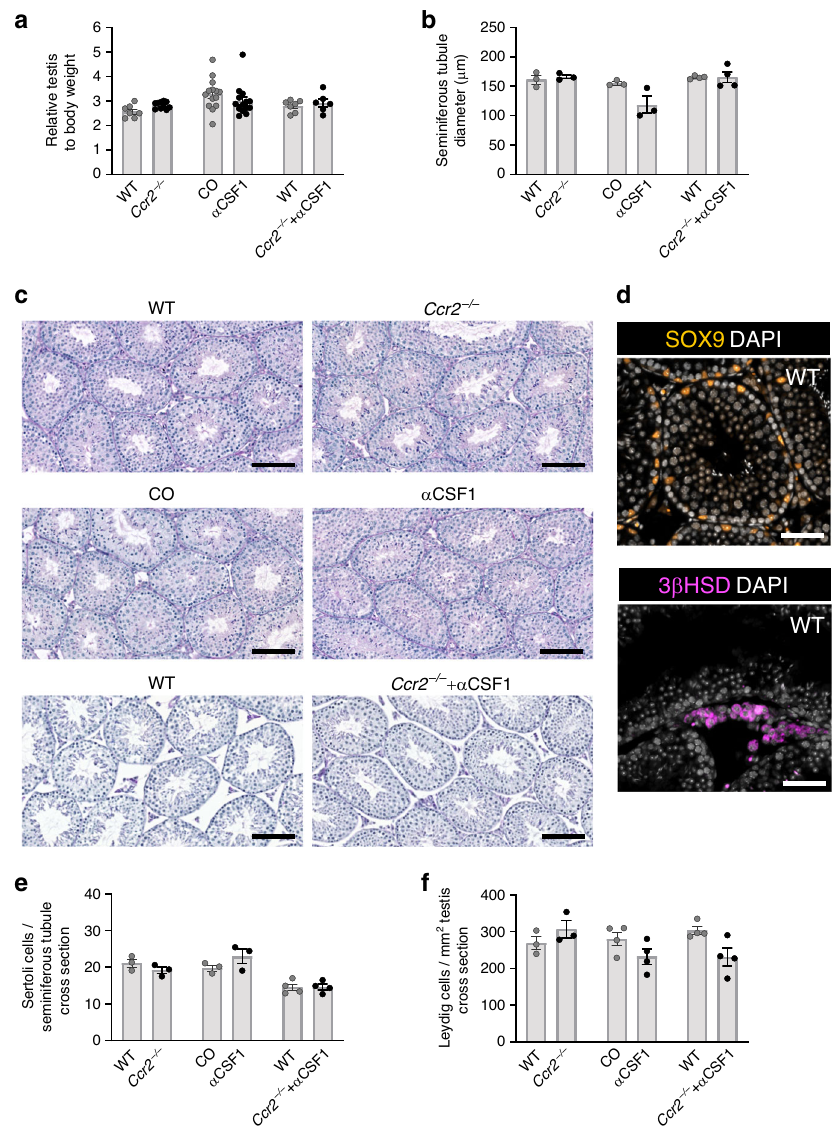
Fig. 6 Spermatogenesis is independent of monocytes or macrophages postnatally. a – f Analyses of testis in 5-week-old Ccr2 − / − mice, wild-type (WT) mice treated with CSF1 antibody at birth ( α CSF1), and Ccr2 − / − mice treated with CSF1 antibody at birth ( Ccr2 − / − + α CSF1), and in their appropriate controls (WT, wild-type mice; CO, isotype-matched control antibody-treated mice). a Relative weight of testis (testis weight (mg)/body weight (g)). b Diameter of the seminiferous tubule. c Histology of testis (PAS stainings). d Representative images of immunohistological stainings for Sertoli cells (SOX9) and Leydig cells (3 β HSD), white is DAPI. e Numbers of Sertoli cells per seminiferous tubule cross-section. f Numbers of Leydig cells per cross-sectional testicular area. Shown are representative images of three mice. Scale bars c 100 µ m, d 50 µ m. In the quanti fi cations, each dot represents one mouse( n = 3 ( b , e , f: WT, Ccr2 − / − , CO, α CSF1), 4 ( b , e , f: WT,: Ccr2 − / − + α CSF1), 6 ( a : Ccr2 − / − + α CSF1), 7 ( a :WT), 10 ( a : Ccr2 − / − ), or 14( a :CO, α CSF1) mice). Data are presented as mean ± SEM. All data are from 2 – 3 independent experiments. Source data are provided as a Source Data fi